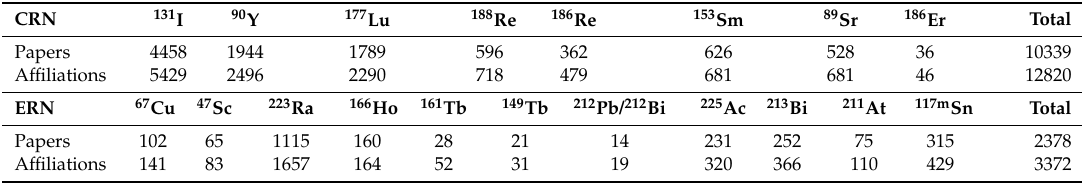
Table 10. Comparison of total publications, affiliation number for each radionuclide, and category of